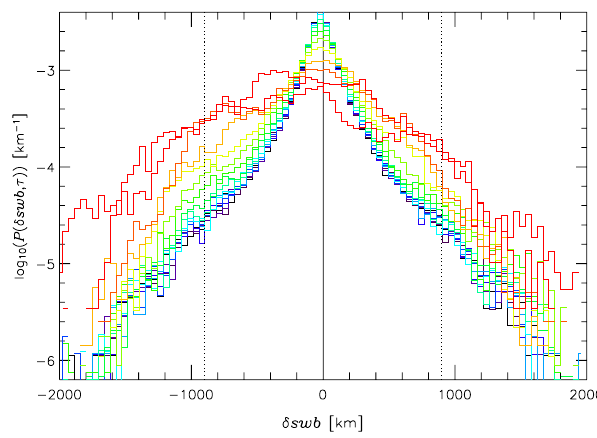
Fig. 7. Probability density functions (PDFs) of fluctuations in the SWB location (km) identified using a threshold of 100ms − 1 throughout ∼ 32 days of discretionary time during 4 December 2005 to 21 November 2006. The different curves correspond to temporal scales τ =1s (black), 2s (violet), ..., 524288s (6.1 days) (red). The PDFs were calculated using a bin size of